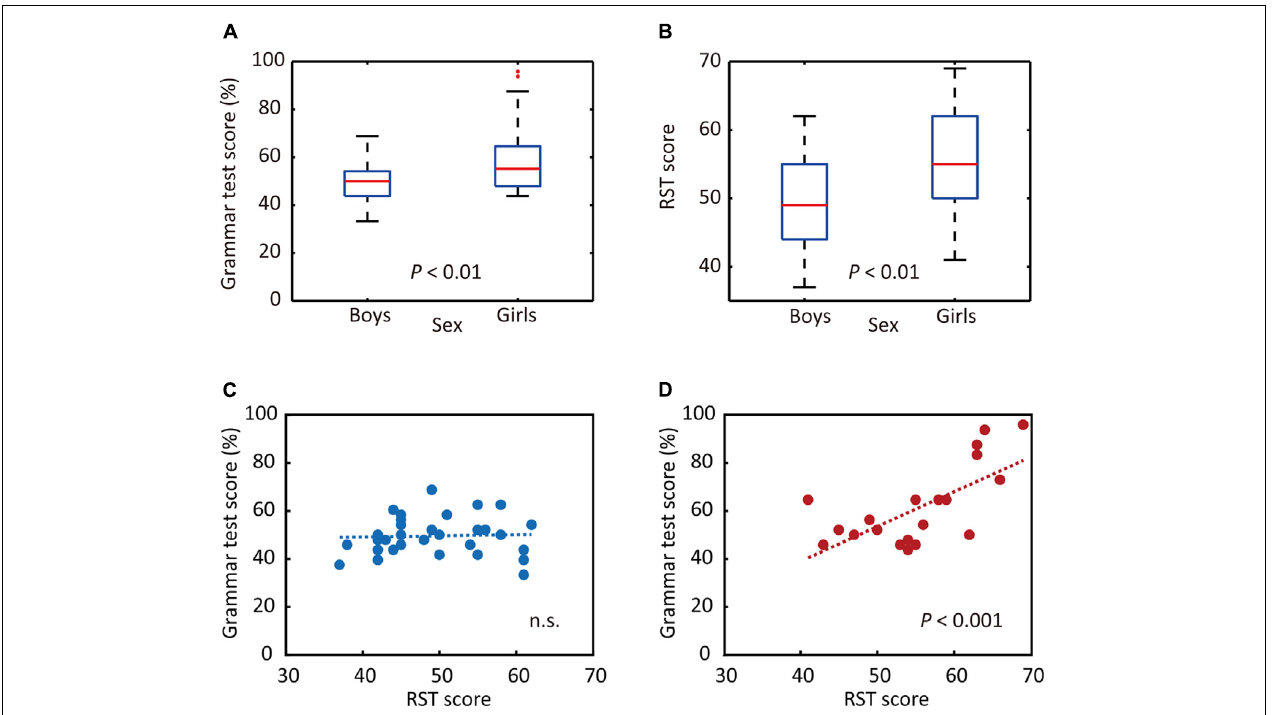
FIGURE 2 | Sex differences in behavioral responses. (A) Sex differences in grammar listening test (Grammar_L) scores. (B) Sex differences in RST scores. (C) Relationship between RST and Grammar_L scores for boys. (D) Relationship between RST and Grammar_L scores for girls. While there was no significant relationship between RST and Grammar_L scores for boys (C) , there was a significant positive relationship between them for girls (D)